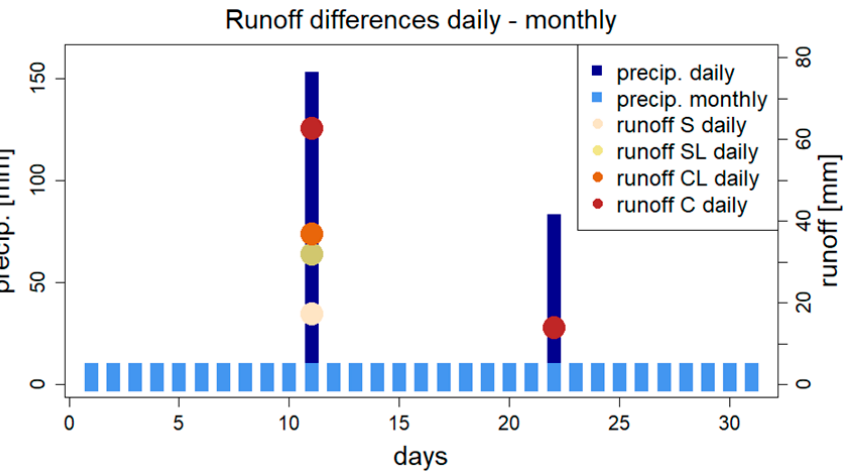
Figure 6. Runoff magnitude simulated by 3-PG-Hydro on daily and monthly resolution with each soil preset (sand (S), sandy loam (SL), clay loam (CL) and clay (C)) and modified precipitation data.